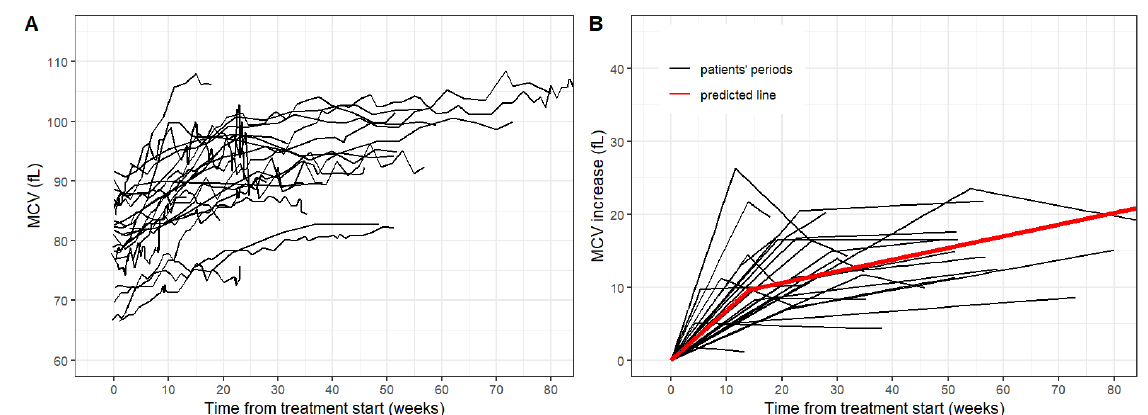
Figure 3. ( A ) Time-courses of MCV. ( B ) Fit regression models with broken-line relationships (black) and common predicted line (red) for pediatric cohort.